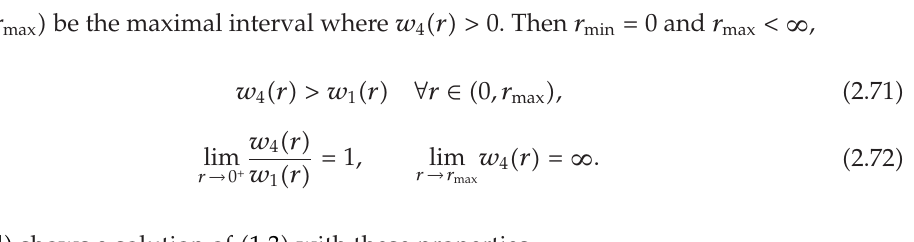
Figure 1 (cid:3) d (cid:4) shows a solution of (cid:3) 1.3 (cid:4) with these